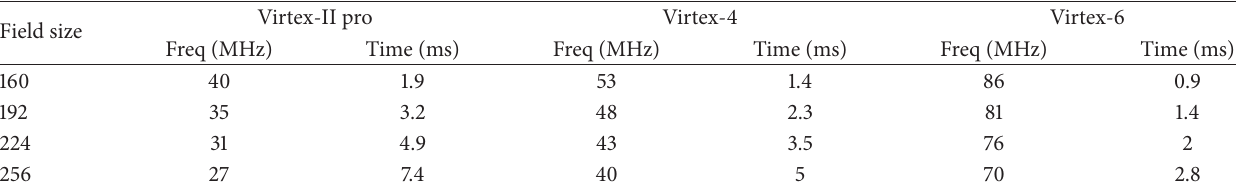
Table 3: Performance evaluation on different FPGA platforms.